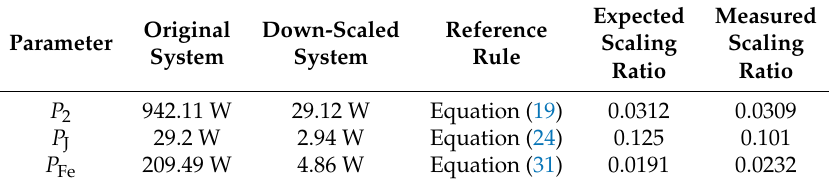
Table 5. Transferred power and losses of starting and down-scaled